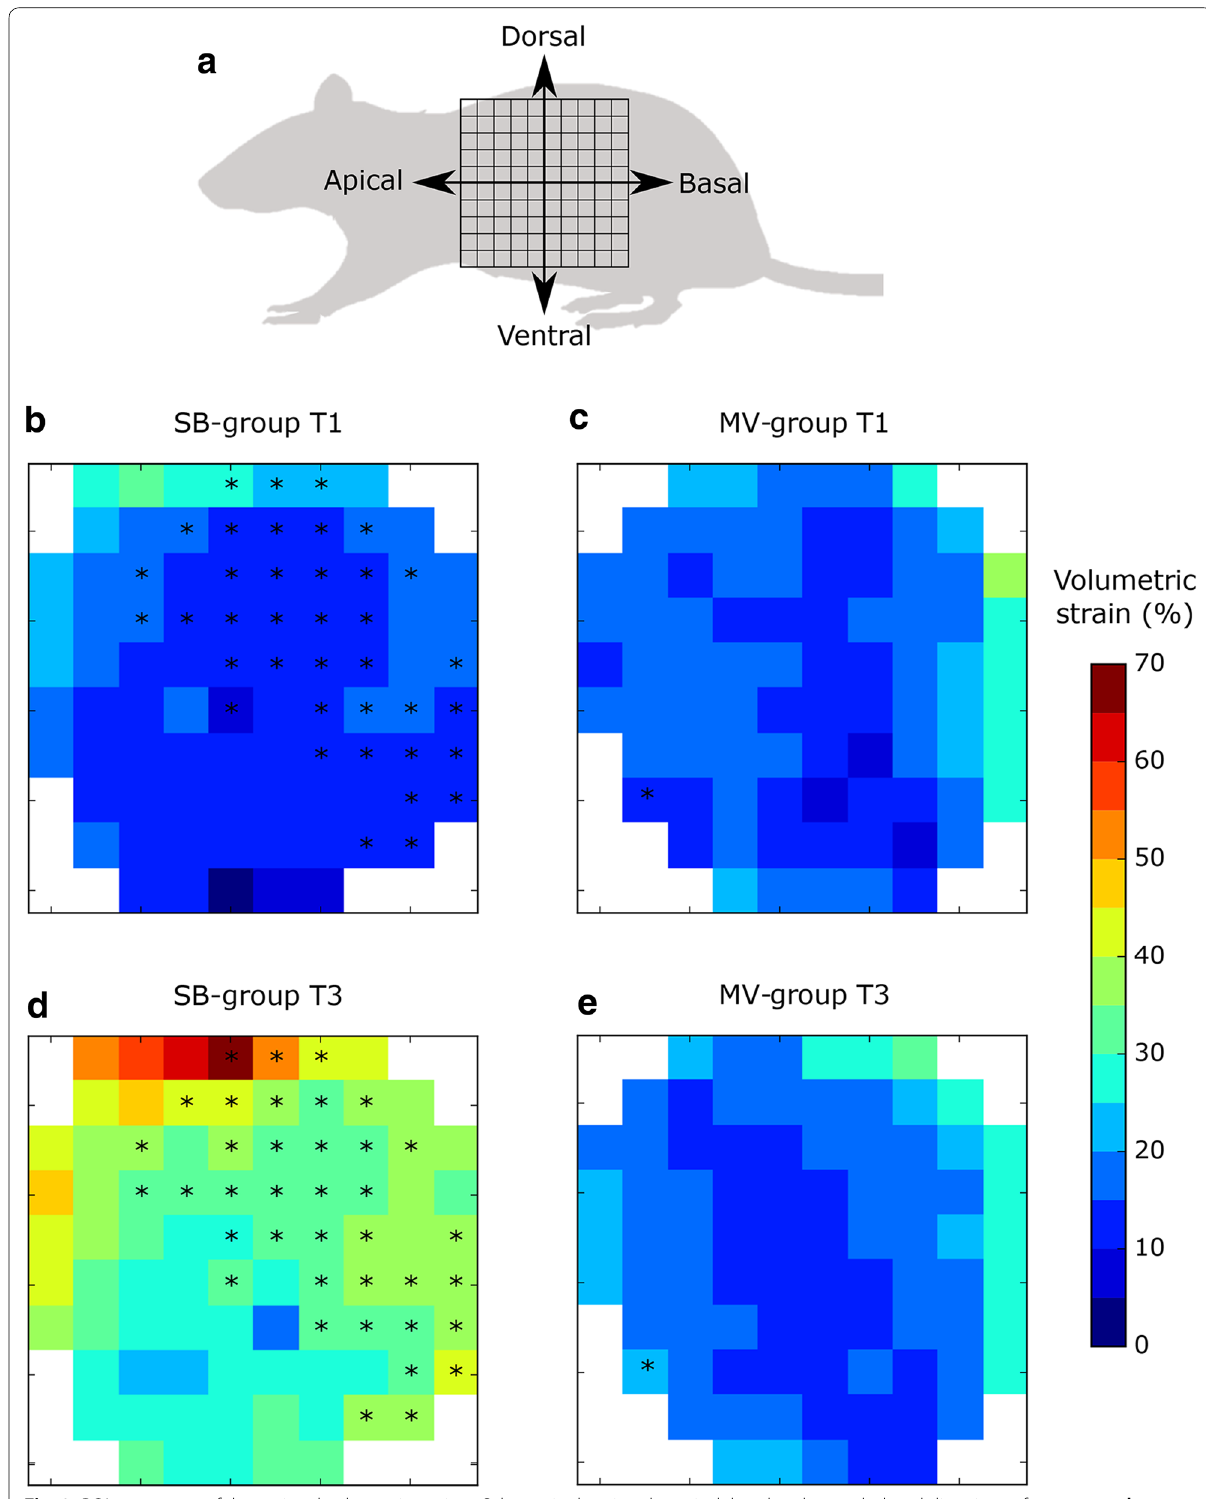
Fig. 2 ROI array maps of the regional volumetric strain. a Schematic showing the apical–basal and ventral–dorsal directions of array maps. b Regional strain in the SB‑group at T1. c Regional strain in the MV‑group at T1. d Regional strain in the SB‑group at T3. e Regional strain in the MV‑group at T3. Significant within‑subject differences are denoted by * ( p <